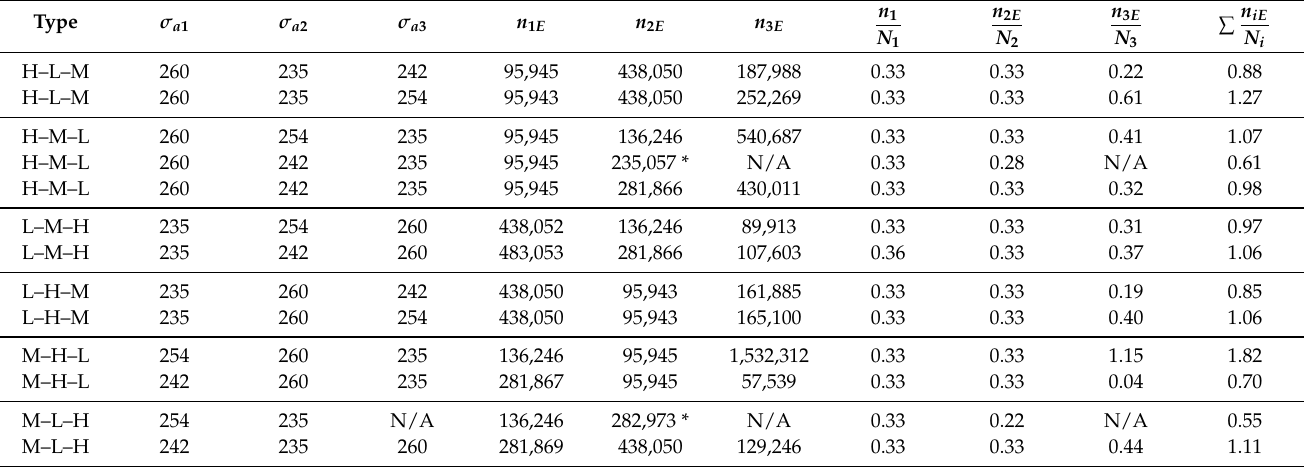
Table A7. Experimental results three-level block loading, specimens extracted from the trans- verse direction.